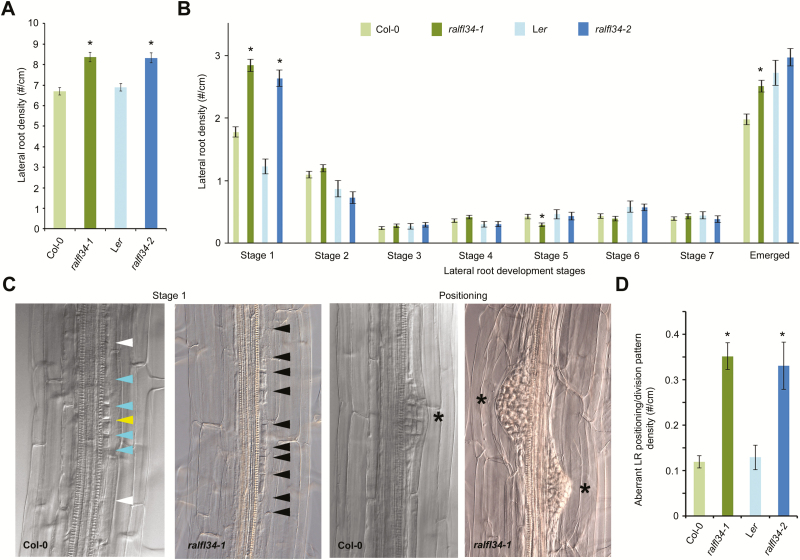
Lateral root phenotypes in ralfl34 mutants. (A, B) Lateral root density in ralfl34-1 (n=69) and ralfl34-2 (n=29) compared with their respective controls, Col-0 (n=79) and Ler (n=20) depicted as total lateral root density, including all stages (A) and split into lateral root stages 1–7 and emerged lateral roots (according to Malamy and Benfey, 1997) (B) at 7 d after germination. Stage 1 includes regions with extra pericycle cell divisions. (C, D) Representative DIC pictures (C) and quantification (D) of aberrant stage 1, additional pericycle divisions, or unusually positioned lateral roots in ralfl34-1 (n=69) and ralfl34-2 (n=29) compared with their respective controls, Col-0 (n=79) and Ler (n=20). An asterisk indicates a lateral root primordium. Arrowheads separate pericycle cells: central (yellow) and outer position (white) for adjacent pericycle cells undergoing two rounds of asymmetric cell divisions (blue) and extra rounds of divisions (black). All graphs show the average ±SE of the indicated sample numbers. *P<0.05 according to Student’s t-test compared with control.